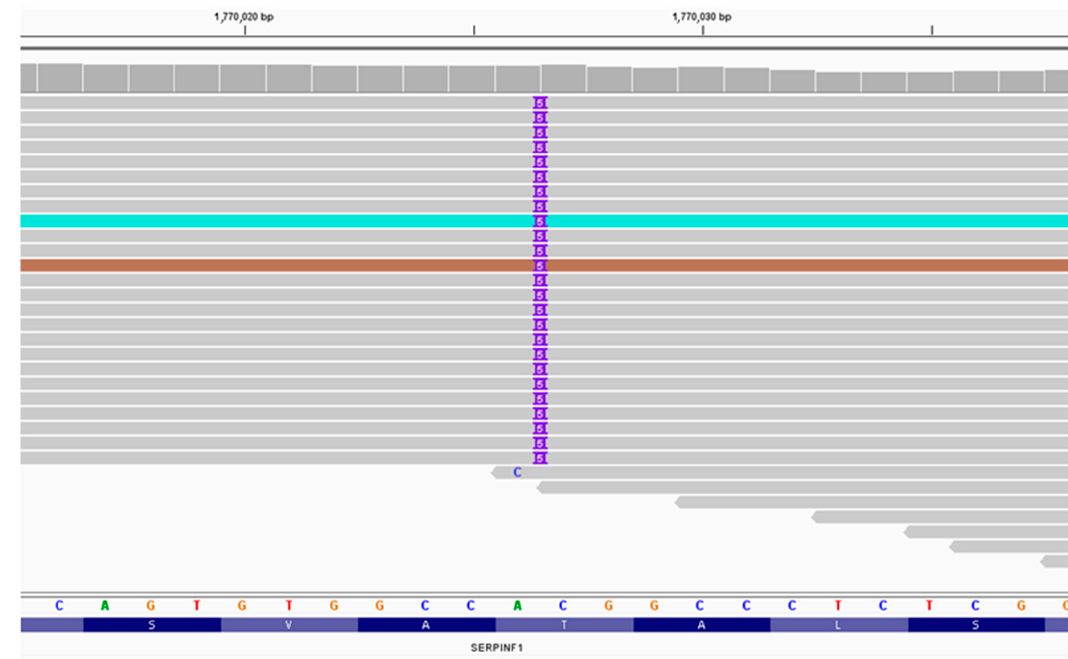
Figure 1. NGS sequencing (IGV browser).